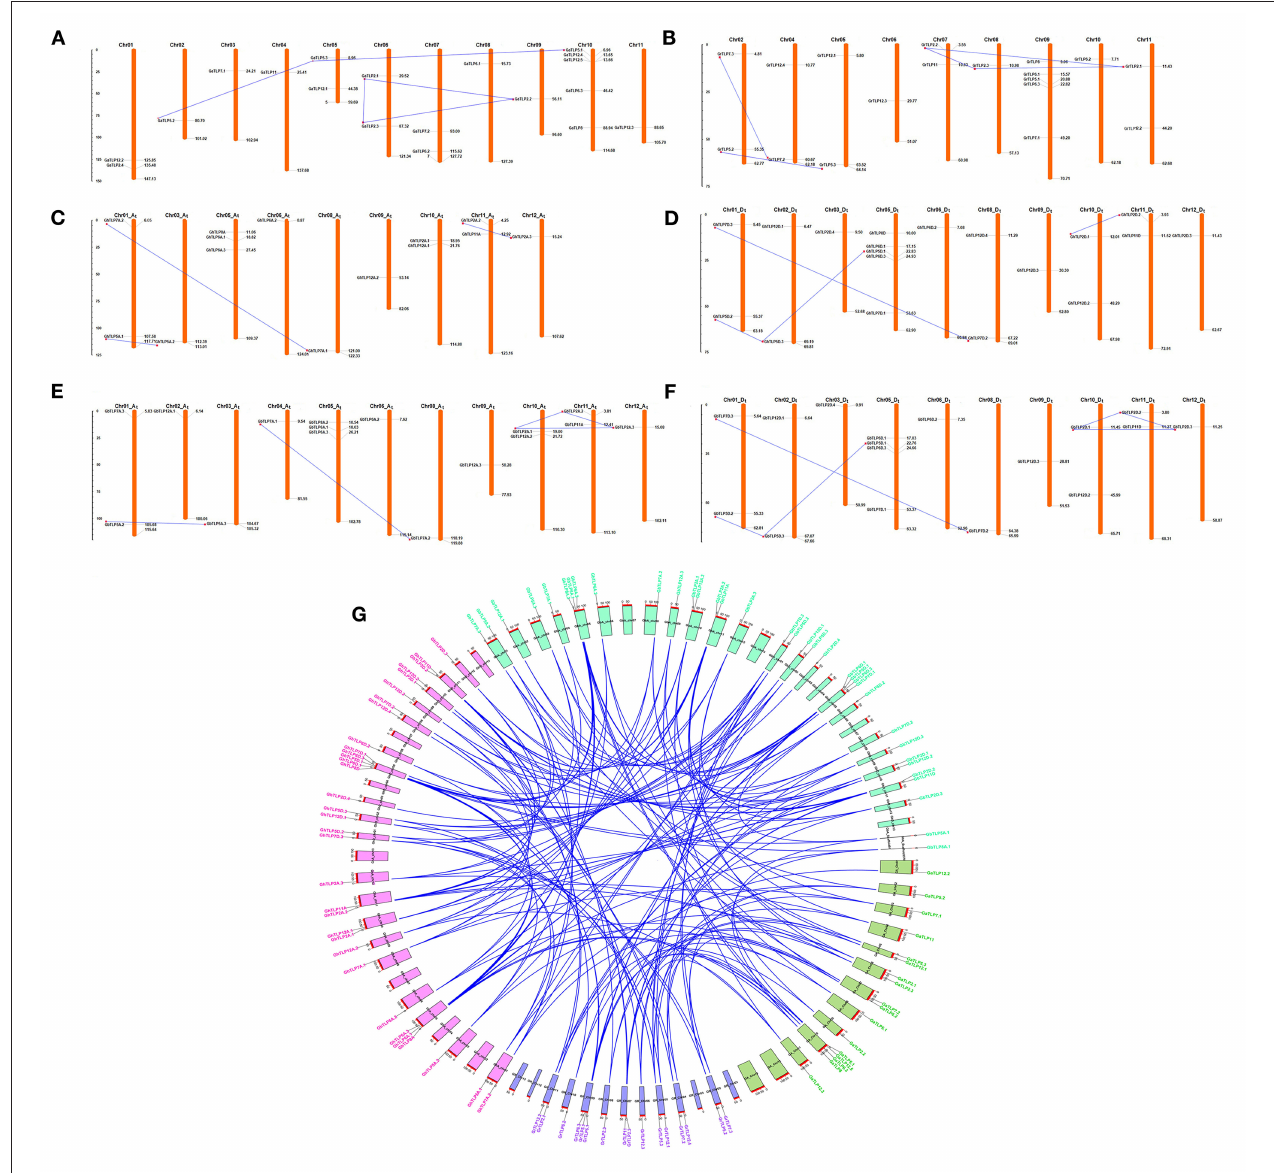
FIGURE 4 | Chromosomal arrangement and paralogous gene duplication of TLP genes on the four genomes of Gossypium . A physical map of chromosomes demonstrates the position of TLP genes on A, D, and AD genomes, respectively. The paralogous TLP genes (segmental gene duplication) linked with blue lines. The locations of each TLP genes are represented through the horizontal gray lines. The numbers of chromosomes are showed at the top. (A,B) Represent the distribution of TLP genes in G. arboreum and G. raimondii genomes, (C,D) showed the arrangement of TLP genes in G. hirsutum genome, and (E,F) represented the TLP genes in G. barbad ense genome, respectively. The scale is in mega bases (Mb). (G) The orthologous TLP duplicated genes pairs among four cotton genomes ( G. arboreum, G. raimondii, G. hirsutum , and G. barbadense ) were also shown with blue lines, and CIRCOS was used to visualize this plot. The gene name and the chromosome